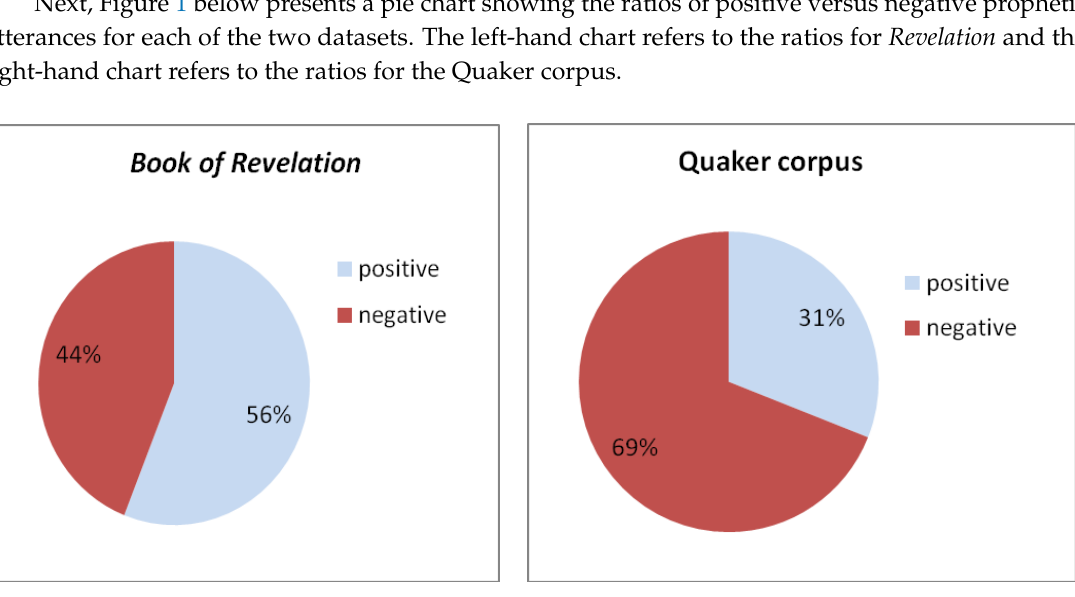
Figure 1. Simple ratios of negative to positive connotations in the Book of Revelation and the Quaker corpus.